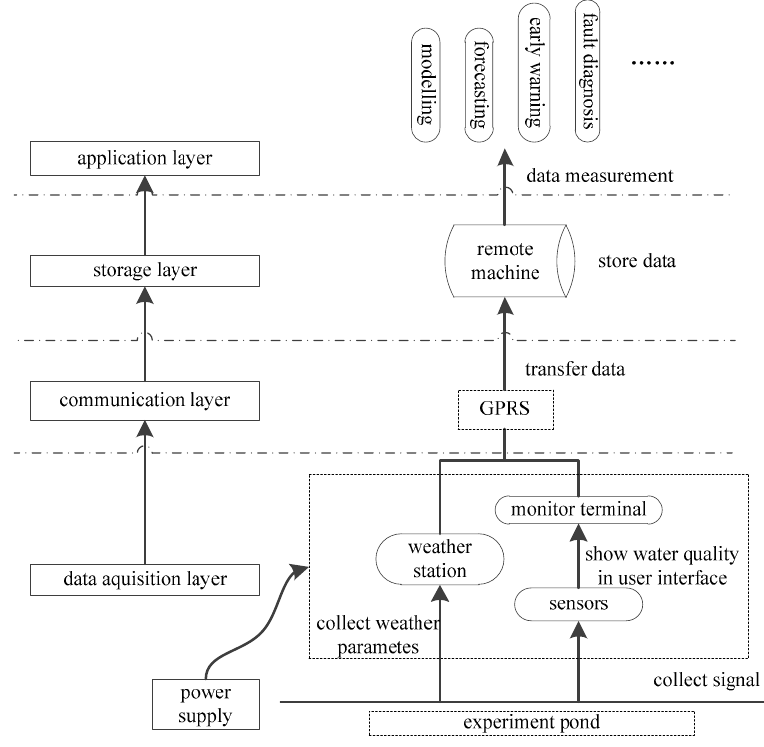
Figure 1. Structure of the aquaculture IoT.